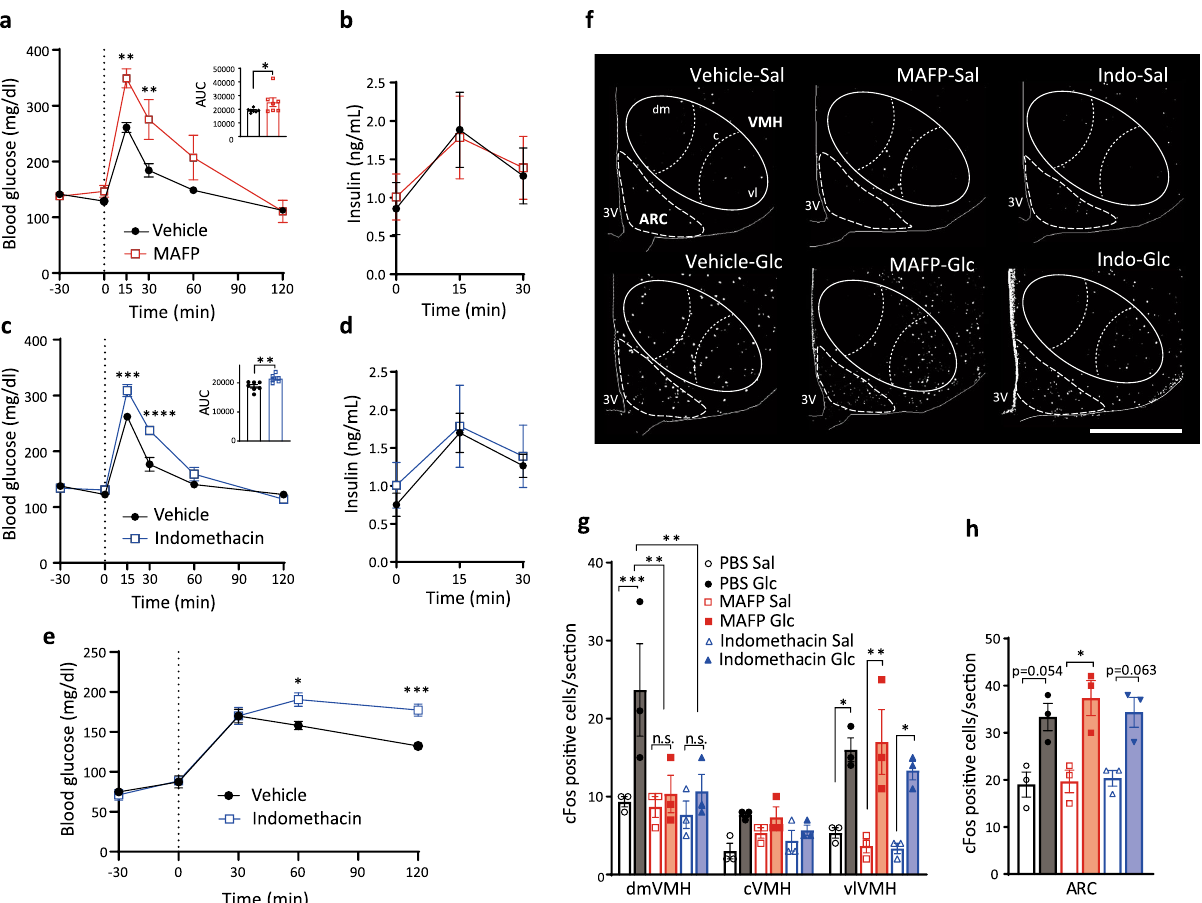
Fig. 2 Hypothalamic PLA2- and COX-mediated AA metabolism regulates systemic glucose tolerance and modulates glucose responsiveness in the dmVMH. a Glucose tolerance test (GTT; 0 – 120 min) after intra-hypothalamic injection ( − 30 min) of MAFP ( n = 7) or vehicle ( n = 7; two-way ANOVA followed by Sidak multiple comparison test, p = 0.0065 at time = 15, p = 0.0045 at time = 30, MAFP vs Vehicle; two-tailed t test in area under the curve (AUC) during GTT, p = 0.0422, MAFP vs Vehicle). b Blood insulin concentration of MAFP ( n = 6) or vehicle ( n = 6) injected mice during GTT. c GTT (0 – 120 min) after intra-hypothalamic injection ( − 30 min) of indomethacin ( n = 6) or vehicle ( n = 7; two-way ANOVA followed by Sidak multiple comparison test, p = 0.0002 at time = 15, p < 0.0001 at time = 30, indomethacin vs Vehicle; two-tailed t test in AUC during GTT, p = 0.0074, indomethacin vs Vehicle). d Blood insulin concentration of indomethacin ( n = 6) or saline ( n = 7) injected mice during GTT. e Blood glucose levels in refeeding after intra-hypothalamic injection ( − 30 min) of indomethacin ( n = 6) or vehicle ( n = 5; two-way ANOVA followed by Sidak multiple comparison test, p = 0.0141 at time = 60, p = 0.0004 at time = 120, indomethacin vs Vehicle). f Representative micrographs showing immuno fl uorescent cFos staining in the hypothalamus of saline (upper panels) or glucose (lower panels) injected mice after i.c.v. injection of PBS, MAFP, or indomethacin (indo). Scale bar: 500 μ m. dm dorsomedial, c central, vl ventrolateral part of the VMH. g , h Quanti fi cation of cFos expression in the dorsomedial (dmVMH), central (cVMH), and ventrolateral (vlVMH) subregions of the VMH ( g ) and ARC ( h ) from mice injected with saline or glucose after i.c.v. injection of PBS, MAFP, or indomethacin ( n = 3 in each experimental group; VMH: two-way ANOVA followed by Sidak multiple comparison test, for dmVMH: p = 0.0004 PBS Glc vs PBS Sal, p = 0.0011 PBS Glc vs MAFP Glc, p = 0.0015 PBS Glc vs Indomethacin Glc, for vlVMH, p = 0.0145 PBS Sal vs PBS Glc, p = 0.0011 MAFP Sal vs MAFP Glc, p = 0.0269 Indomethacin Sal vs Indomethacin Glc. For ARC: one-way ANOVA followed by Sidak multiple comparison test, p